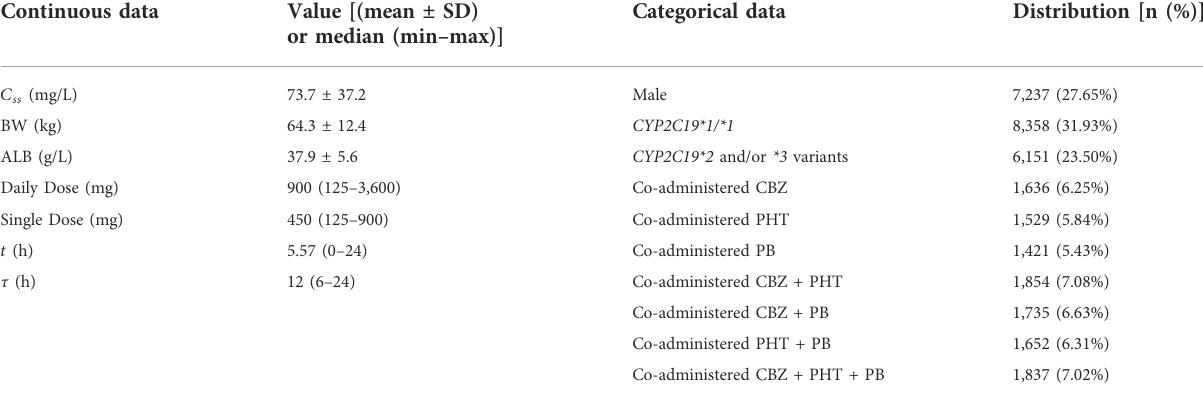
TABLE 3 Simulated patient characteristics in the fi nally generated combined dataset (N = 26,173). Continuous